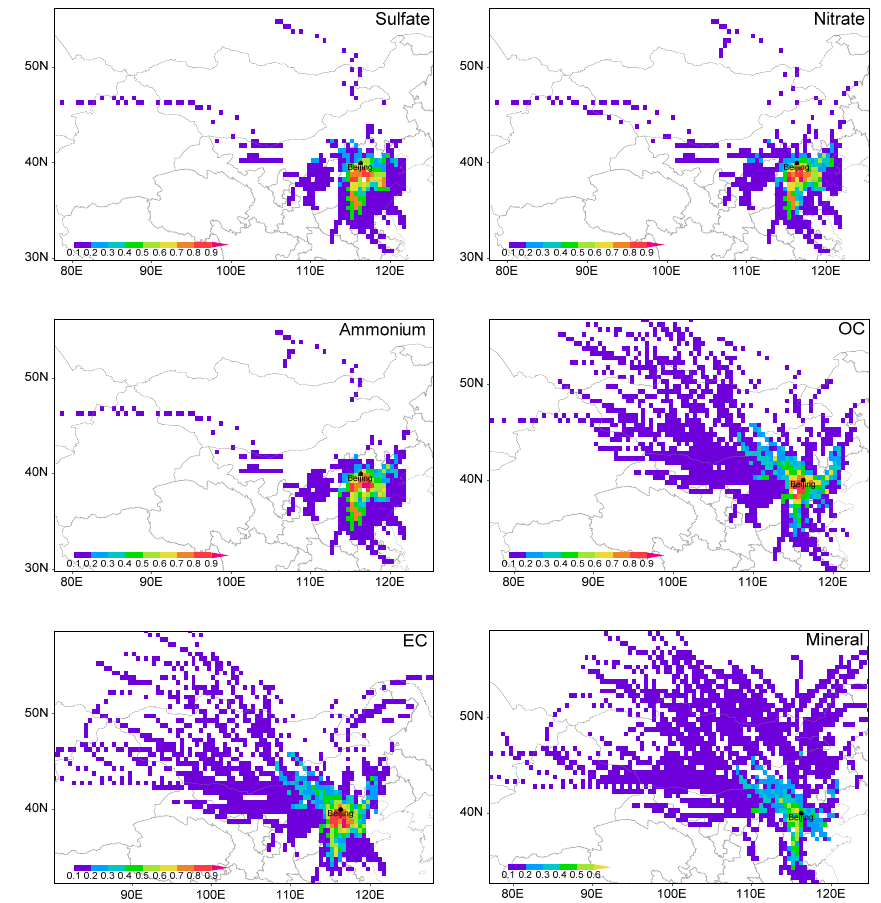
Fig. 11. The PSCF maps for sulfate, nitrate, ammonium, OC, EC, and